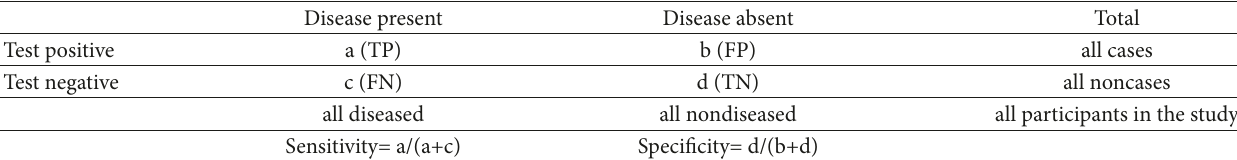
Table 4: Description of sensitivity and specificity [53].